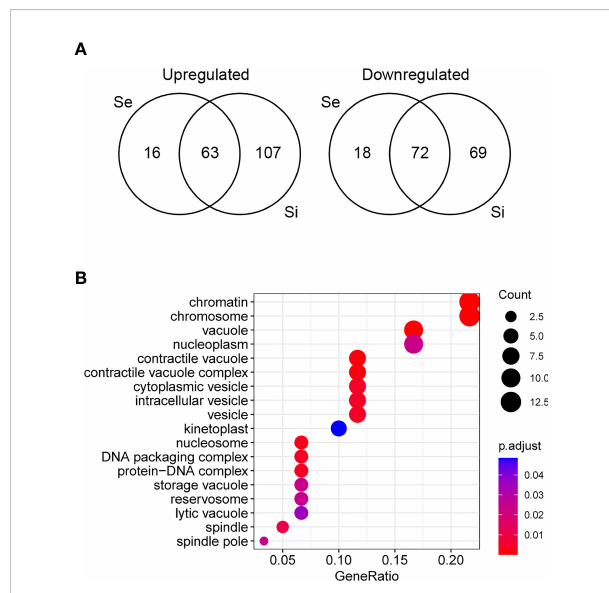
FIGURE 3 Analysis of differentially expressed genes of T. cruzi epimastigotes during prolonged cultures. The identi fi ed DEGs of early and intermediate stationary phase (Se and Si, respectively) in comparison to exponentially growing epimastigotes (E) were analyzed. (A) Venn diagrams. (B) Gene ontology analysis of downregulated Se ⋂ Si vs E DEGs.